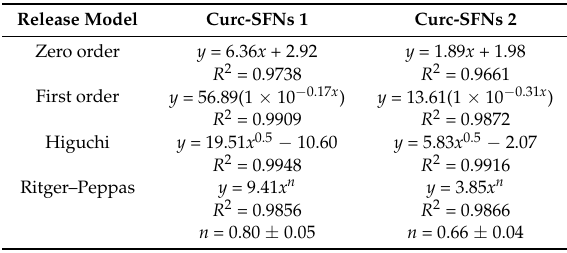
Table 3. Release models of curcumin-loaded silk fibroin nanoparticles synthesized by physical adsorption (Curc-SFNs 1) and curcumin-loaded silk fibroin nanoparticles synthesized by coprecipitation (Curc-SFNs 2).